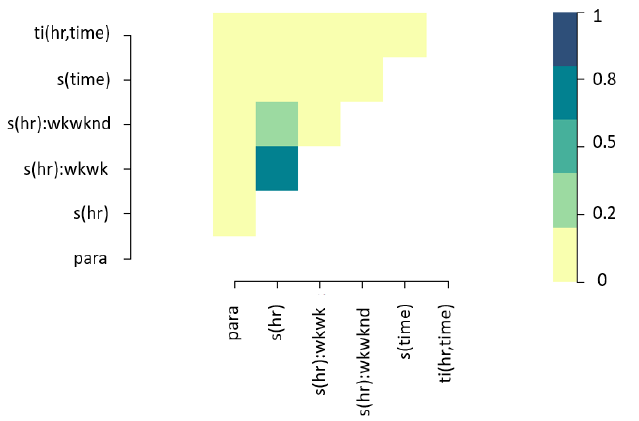
Figure 6. Pairwise estimated concurvity of non-spatial